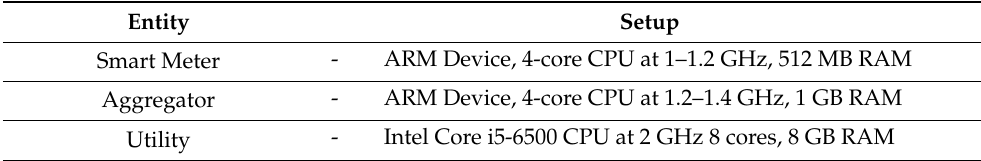
Table 3. SAMGRID testbed parameters for